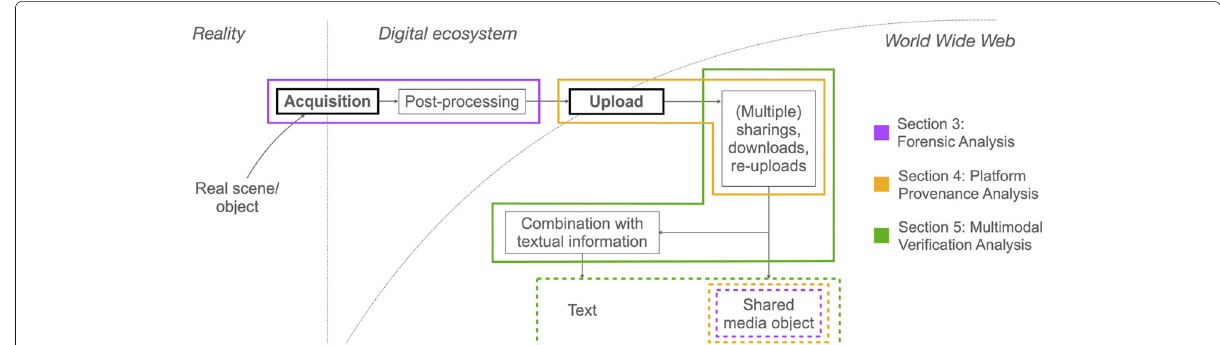
Fig. 1 Visual representation of the research topics reviewed in this survey. Each section corresponds to a color. For each color, solid rectangles highlight the phases studied by the methods reviewed in the corresponding section (i.e., where different hypotheses are defined for the forensic analysis), and dashed rectangles indicate the objects on which the analysis is